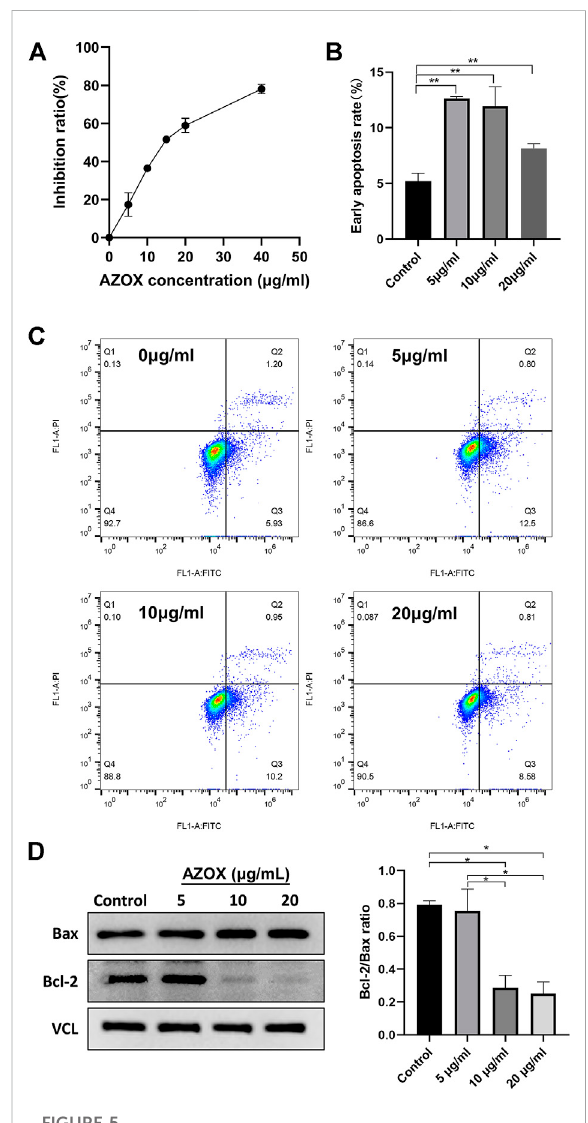
FIGURE 5 AZOX inhibits proliferation and induces apoptosis in DOK cells. (A) CCK8assaywasusedto investigatetheeffectofAZOXon the activity of DOK cells. (B) Bar graph showing fl ow cytometry analysis of early apoptosis rate of DOK cells. (C) Early apoptotic DOK cells were examined through fl ow cytometry. (D) Western blot for the expression of Bax and Bcl-2 in DOK cells after being treated with AZOX at 0, 5, 10, 20 μ g/ml for 48 h,